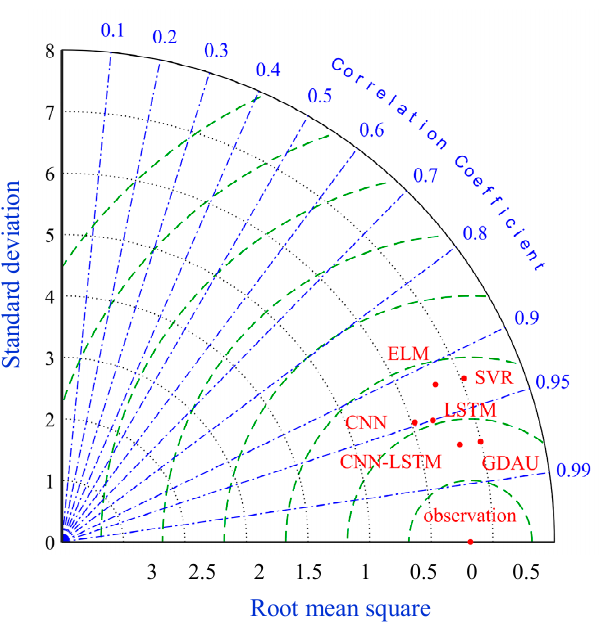
Figure 16. The box plots of error distribution.